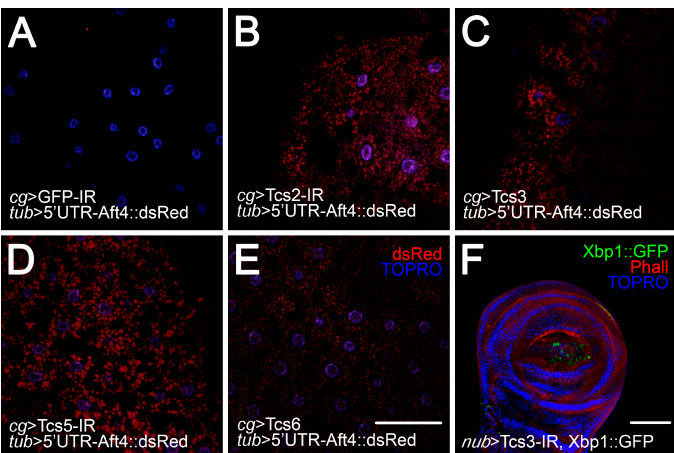
Figure 4. Unfolded protein response (UPR) is activated in larval and imaginal cells deficient of t 6 A modified tRNAs. In vivo UPR activation reporters were used. ( A – E ) Construct in which the 5’UTR of Atf4 mRNA was fused with dsRed and expressed ubiquitously; when the PERK/Atf4 branch of the UPR is activated, dsRed is translated. In this reporter background, t 6 A synthetic machinery was knocked-down exclusively in the fat body using collagen type IV driver ( cg > Gal4). Nuclei were stained with TO-PRO3. Bar 100 µ m; ( F ) tcs3 was knocked-down using the nubbin > Gal4 driver, simultaneously an Ire1 branch UPR reporter was expressed. Upon UPR activation, the Xbp-1::GFP message was spliced and the fusion protein synthetized. F-actin was stained with phalloidin (Phall) and nuclei with TO-PRO3 (TOPRO). Bar 100 µ m.